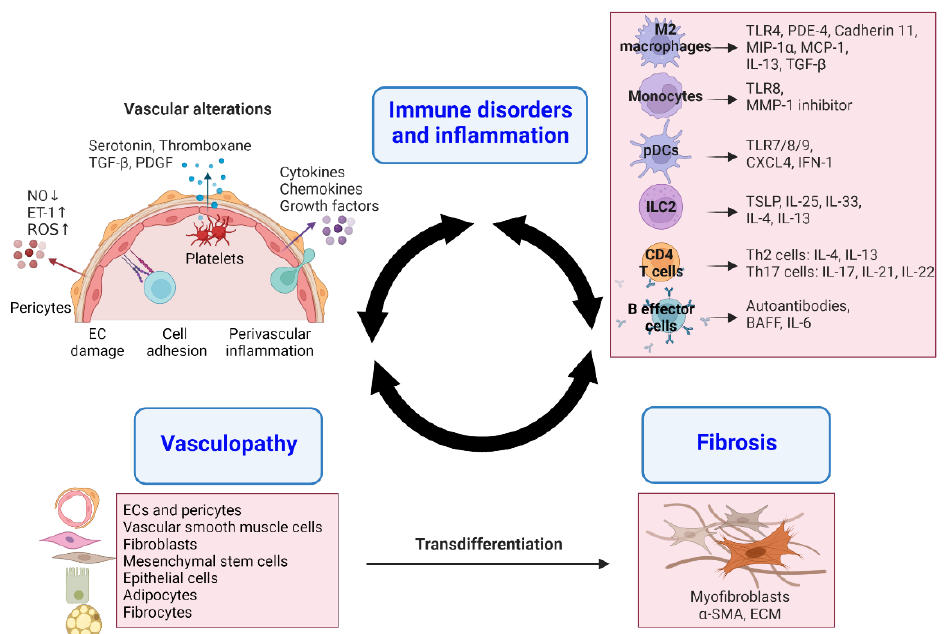
Figure 1. Pathological processes involved in SSc. The main pathophysiological hallmarks of SSc are immune disorders, vasculopathy, and fibrosis in tissues and organs. Diverse innate and adaptive immune cells are involved in EC activation and fibrosis. Vascular alterations and trans-differentiation toward myofibroblasts contribute to inflammation and fibrosis in the perivascular space and surrounding tissues.